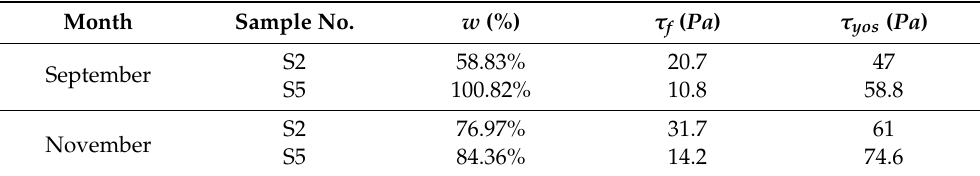
Table 9. Seasonal variations of yield and flow-point stress values obtained from oscillatory tests for samples No. S2 and S5.